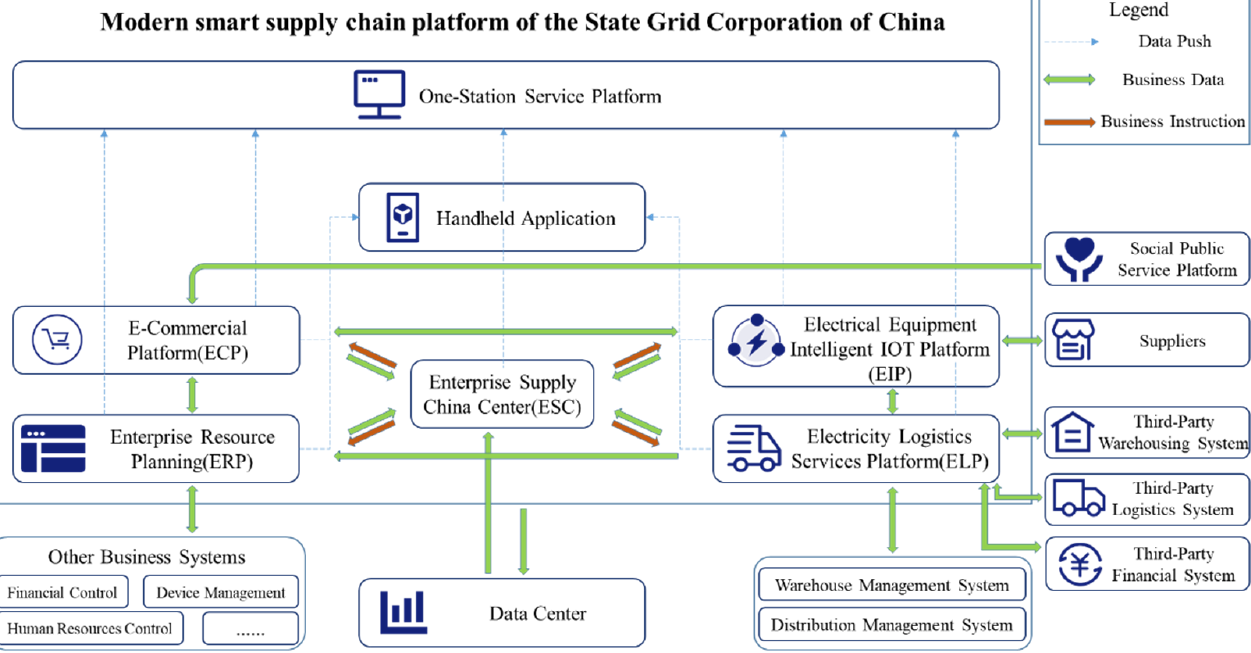
Figure 1. The architecture of the modern smart supply chain platform.